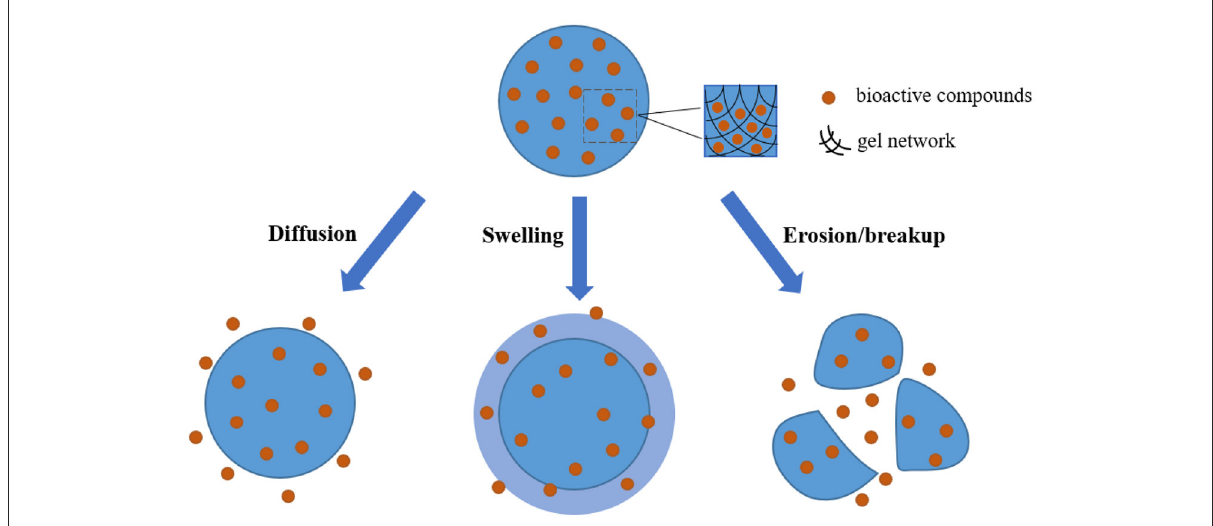
FIGURE3 Schematic illustration of the release behavior of bioactive compounds when hydrogels as carriers are applied in the delivery